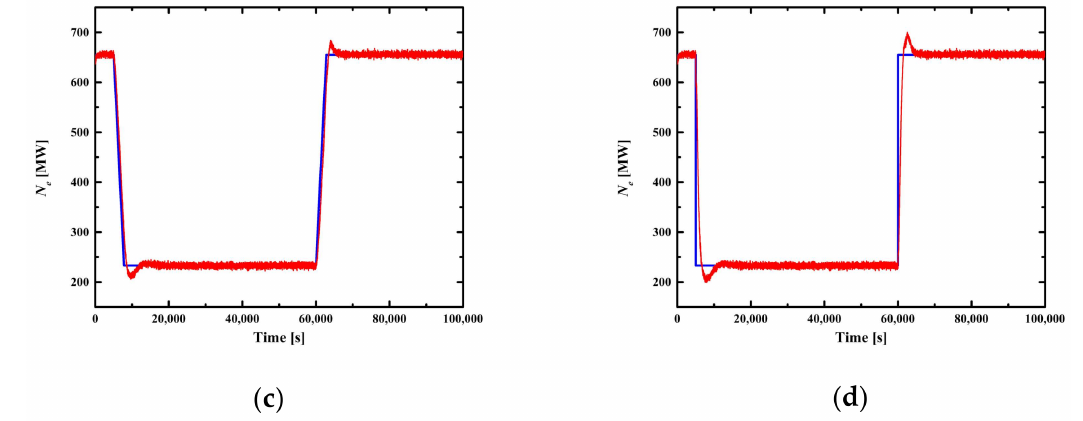
Figure 9. Results of coordinated predictive control for a 660-MW USC CFB unit with: ( a ) 3000 [kW/min]; ( b ) 6000 [kW/min]; ( c ) 9000 [kW/min]; ( d ) step ramp rate as control